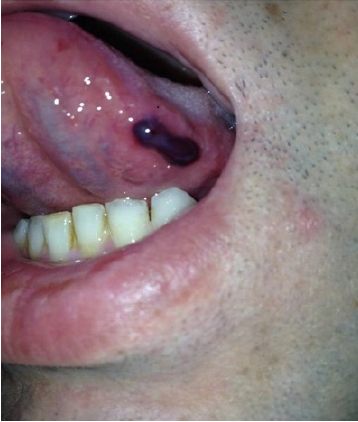
Figure 1. A tense, blood-filled bullae on the tongue.